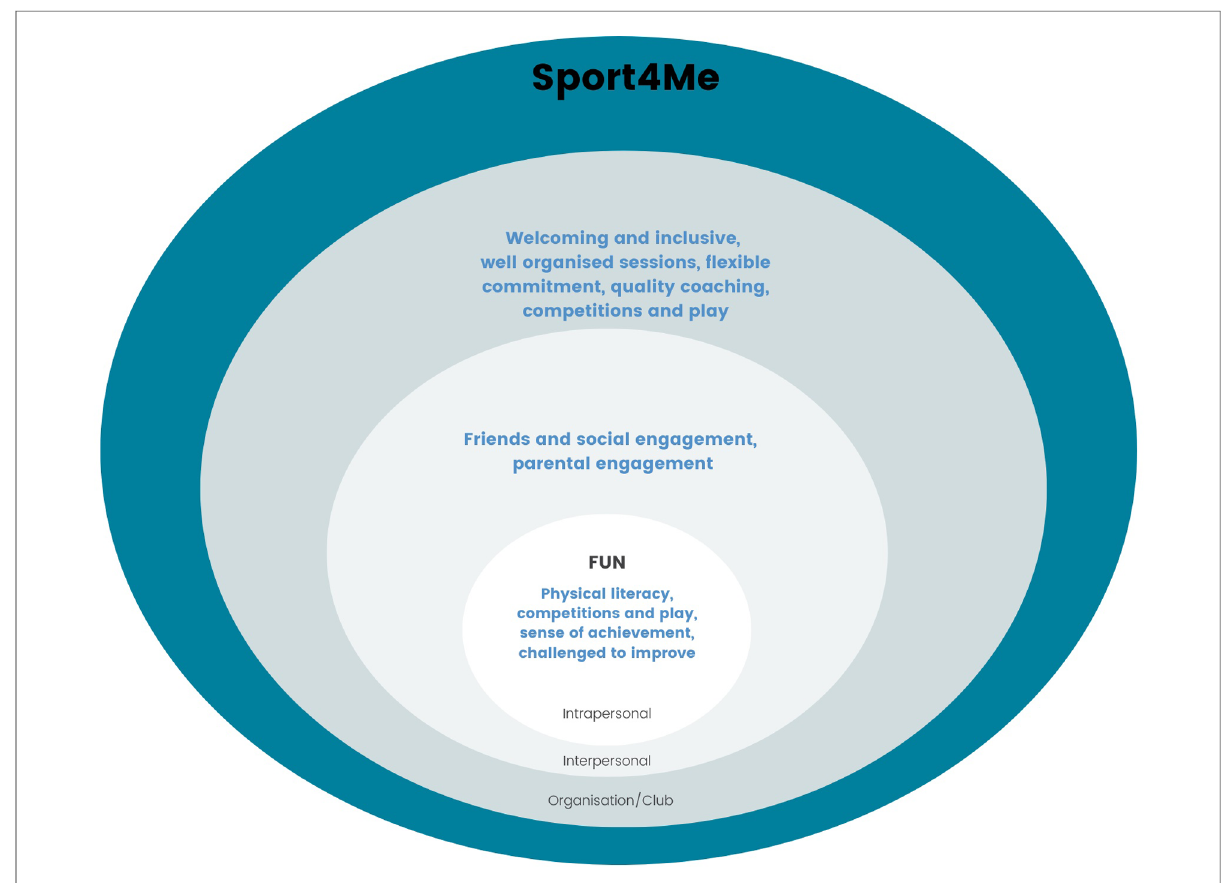
FIGURE 2 Sport4Me conceptual